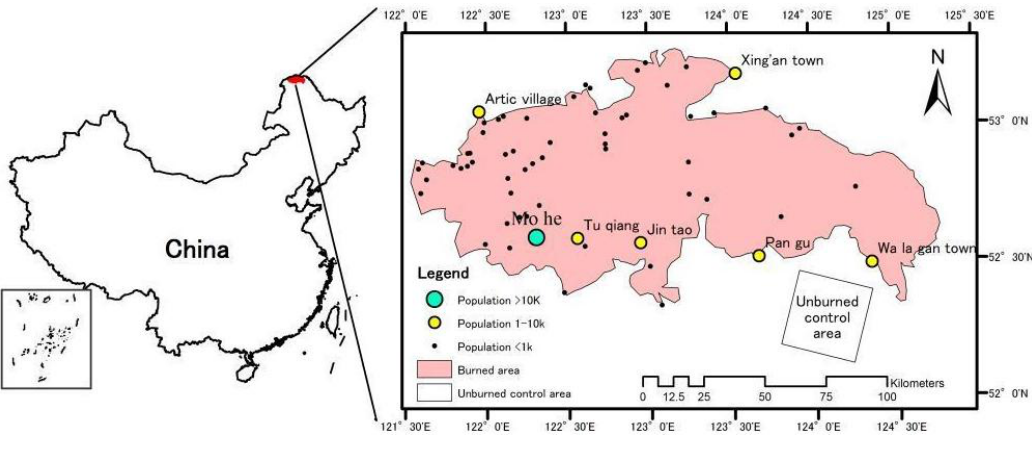
Figure 1. Location of the study